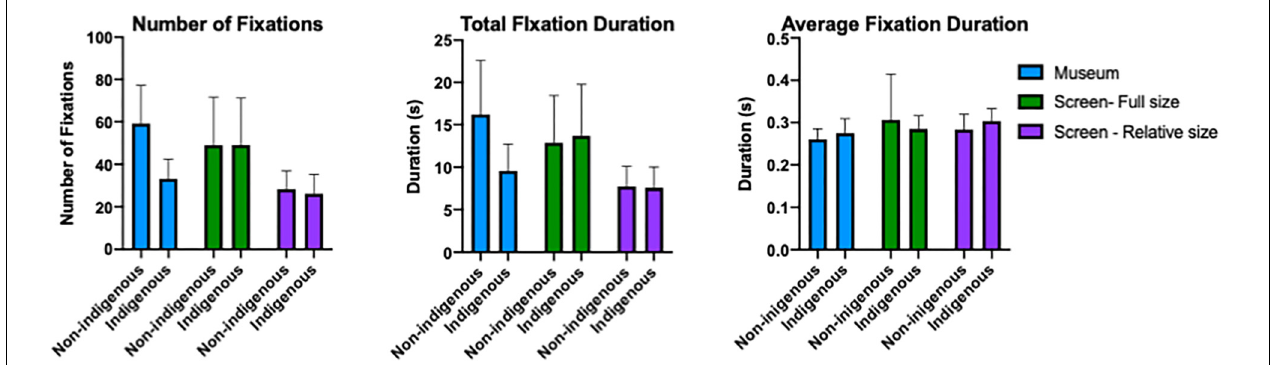
FIGURE 9 | Mean number of fixations, total fixation duration and average fixation length for Indigenous and non-Indigenous paintings in the three presentation conditions (museum; screen, full size; screen, relative size). The error bars represent 95% CI.